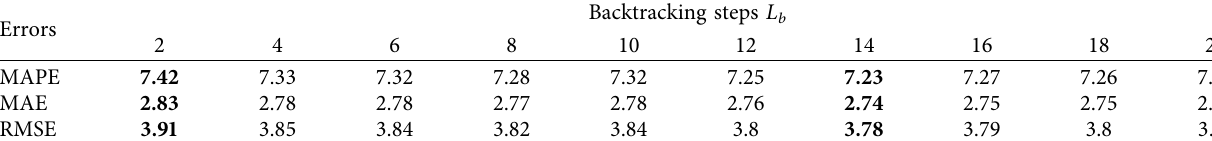
Table 1: Prediction errors of the LSTM model with different backtracking steps on the detector 16,395.